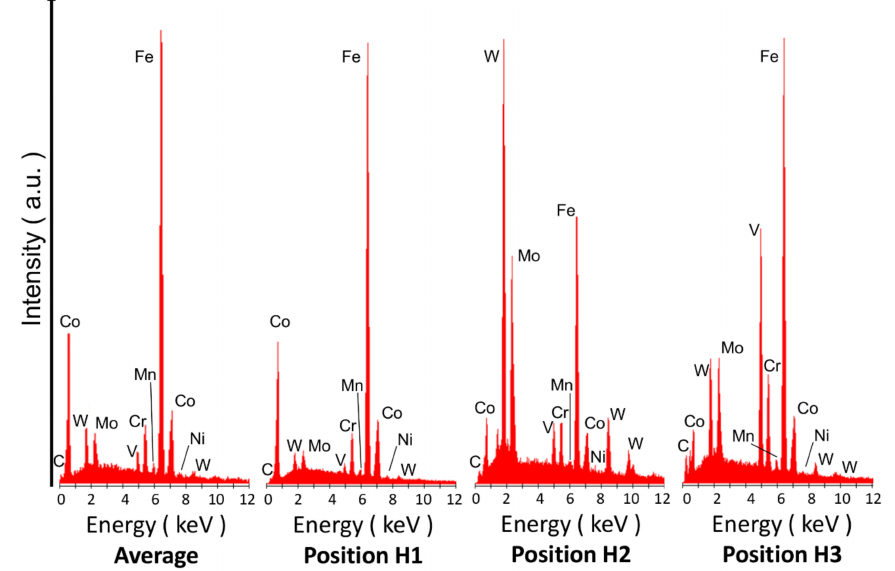
Figure 4. EDS area-averaged over the entire view-field and pointwise spectra at various positions (H1, H2, and H3) of the chemo-mechanically polished surface shown in Figure